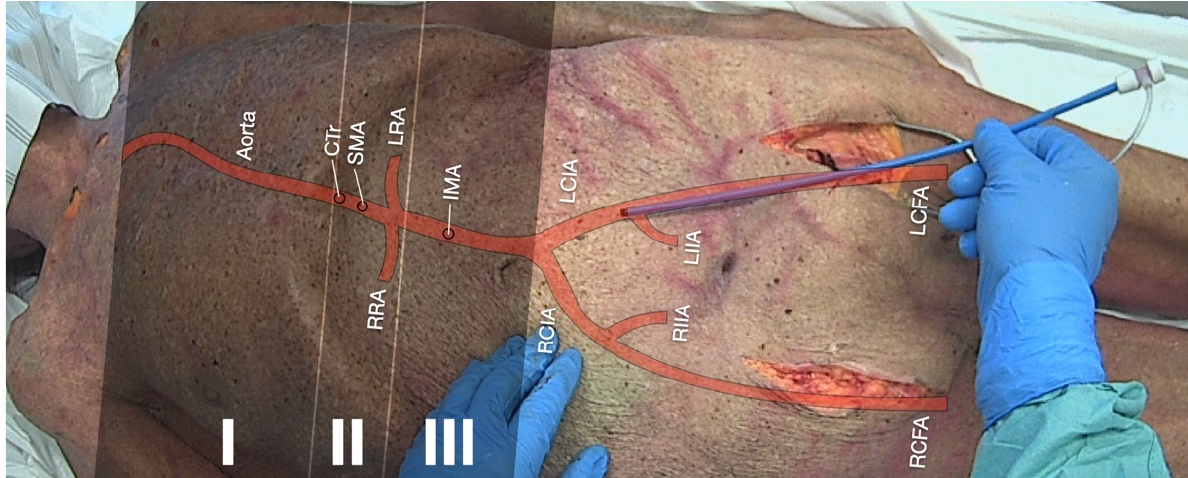
Figure 2. Schematic topographic projection of the aorta and its major branches on a cadaveric model: REBOA landing zones ( I ) (preferred in non-traumatic cardiac arrest), ( II ) (contraindicated), and ( III ) (preferred in pelvic trauma) are highlighted. Both femoral arteries have been prepared via a cutdown approach. Abbreviations: CTr = coeliac trunk, SMA = superior mesenteric artery, RRA = right renal artery, LRA = left renal artery, IMA = inferior mesenteric artery, RCIA = right common iliac artery, LCIA = left common iliac artery, RIIA = right internal iliac artery, LIIA = left internal iliac artery, RCFA = right common femoral artery, and LCFA = left common femoral artery.